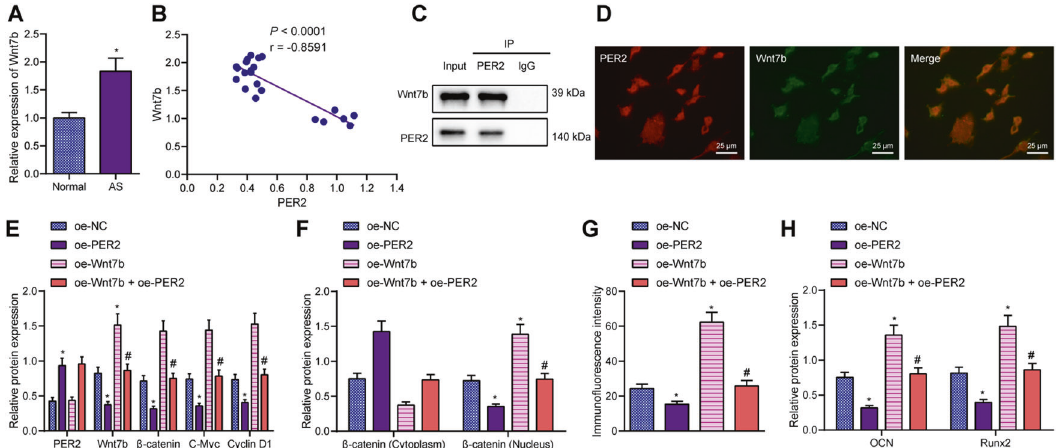
Fig. 5 Effect of PER2 on the Wnt/ β -catenin signaling pathway. A Wnt7b expression in the normal spinal ligaments of patients with spinal fractures ( n = 6) and spinal ligaments of patients with AS ( n = 16) determined by RT-qPCR. B The correlation between Wnt7b and PER2 expression in the spinal ligaments of patients with AS ( n = 16) analyzed by Pearson ’ s correlation coef fi cient. C The interaction between Wnt7b and PER2 in AS-BMSCs detected by Co-IP. D The colocalization of Wnt7b and PER2 in AS-BMSCs detected by immuno fl uorescence staining, scale bar = 25 μ m. E The protein expression of PER2, Wnt7b, and Wnt/ β -catenin signaling pathway-related proteins ( β -catenin, C-Myc, and Cyclin D1) in AS-BMSCs treated with oe-PER2 and/or Wnt7b measured by Western blot analysis. F The protein expression of β -catenin in the cytoplasm and nucleus of AS-BMSCs treated with oe-PER2 and/or Wnt7b detected by Western blot analysis. G Translocation of β -catenin to the nucleus of AS-BMSCs treated with oe-PER2 and/or Wnt7b detected by immuno fl uorescence staining. H The protein expression of Runx2 and OCN in AS-BMSCs treated with oe-PER2 and/or Wnt7b measured by Western blot analysis. * p < 0.05 vs. normal spinal ligaments/AS-BMSCs treated with oe-NC. # p < 0.05 vs. AS-BMSCs treated with oe-PER2. The cell experiment was repeated three times independently.